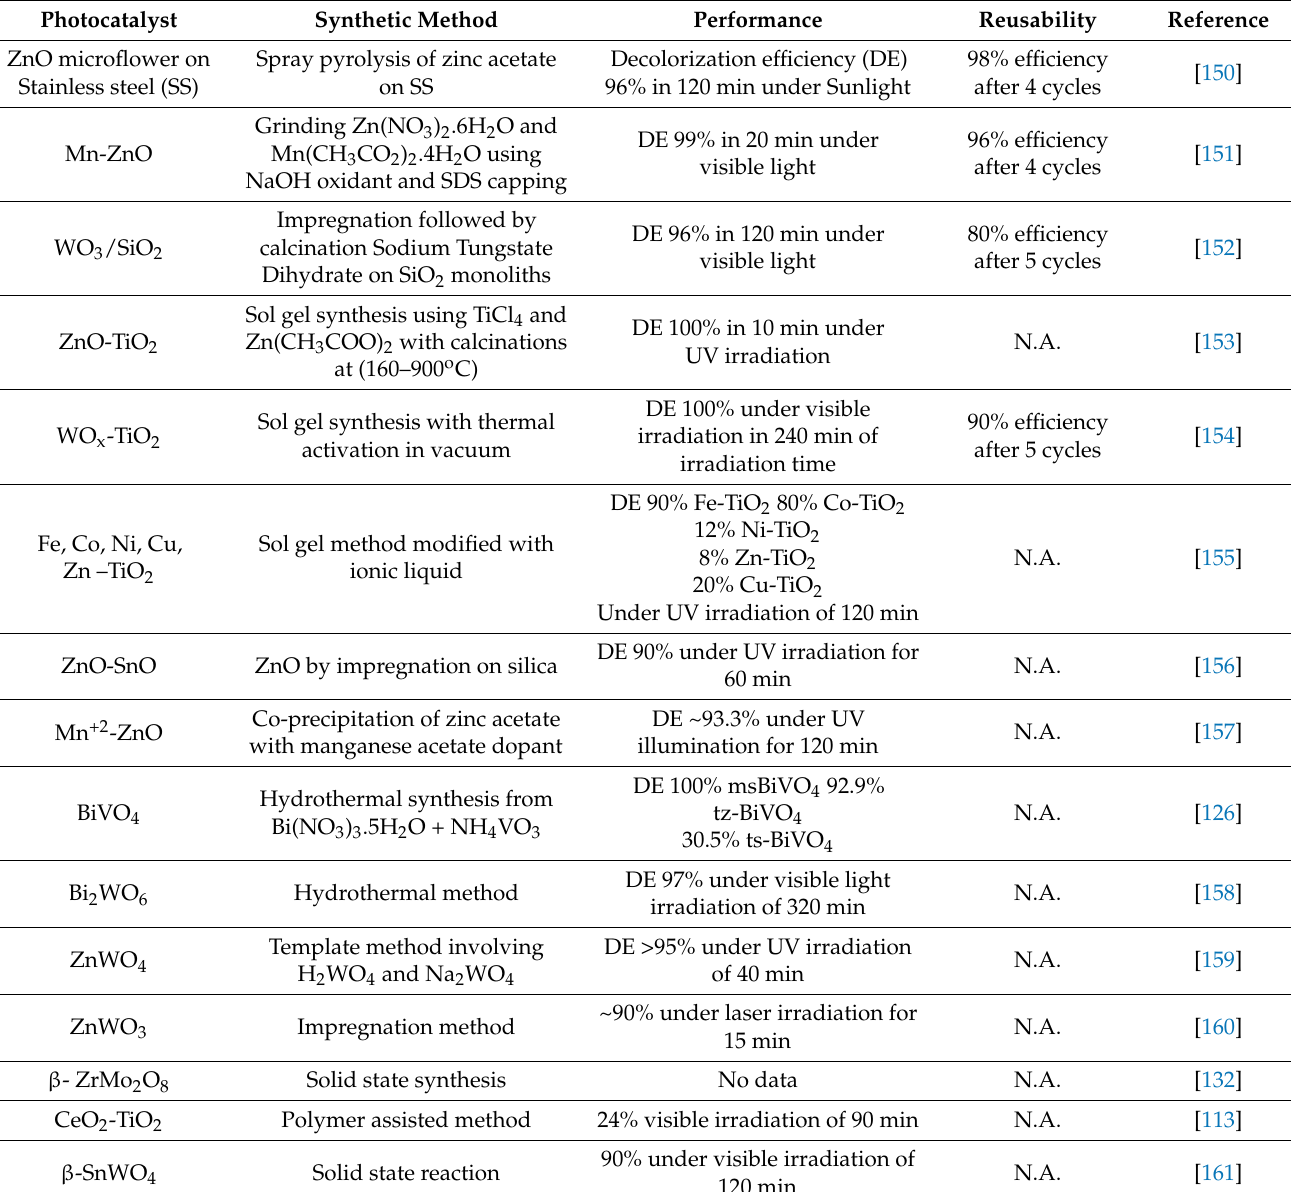
Table 1. Photocatalytic performance of bimetallic transition metal oxides. N.A. = data not